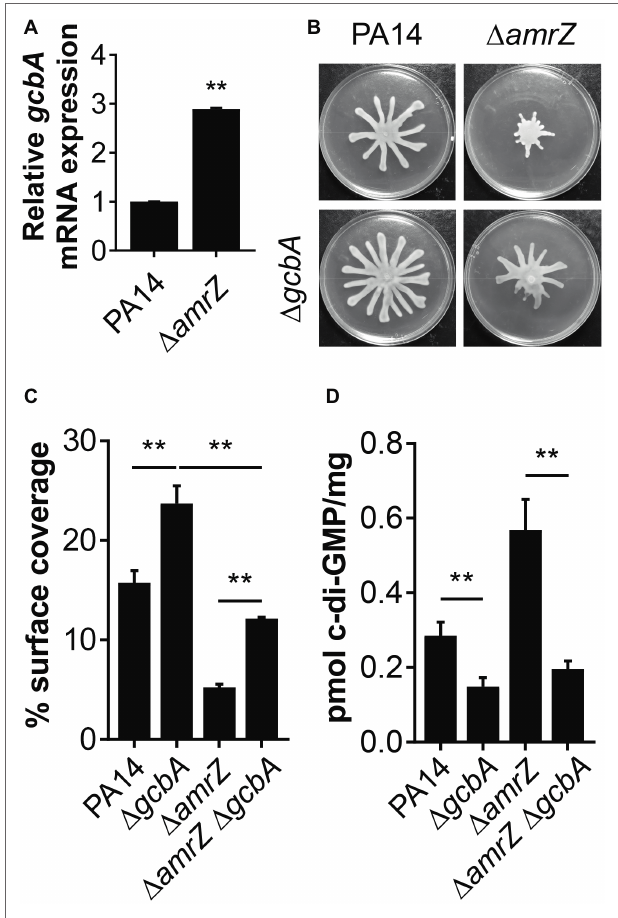
FIGURE 4 | GcbA is required for increased c-di-GMP accumulation in ∆ amrZ and partially responsible for its swarming phenotype. (A) Relative mRNA levels of gcbA in indicated strains under swarming conditions as determined by real-time PCR. (B) Representative images of swarming motilities of indicated strains. (C) Percent coverage of swarm plates by the respective swarms. (D) Quantification of c-di-GMP levels of the indicated strains grown on swarm plates. ** p < 0.01 as determined by Student’s t